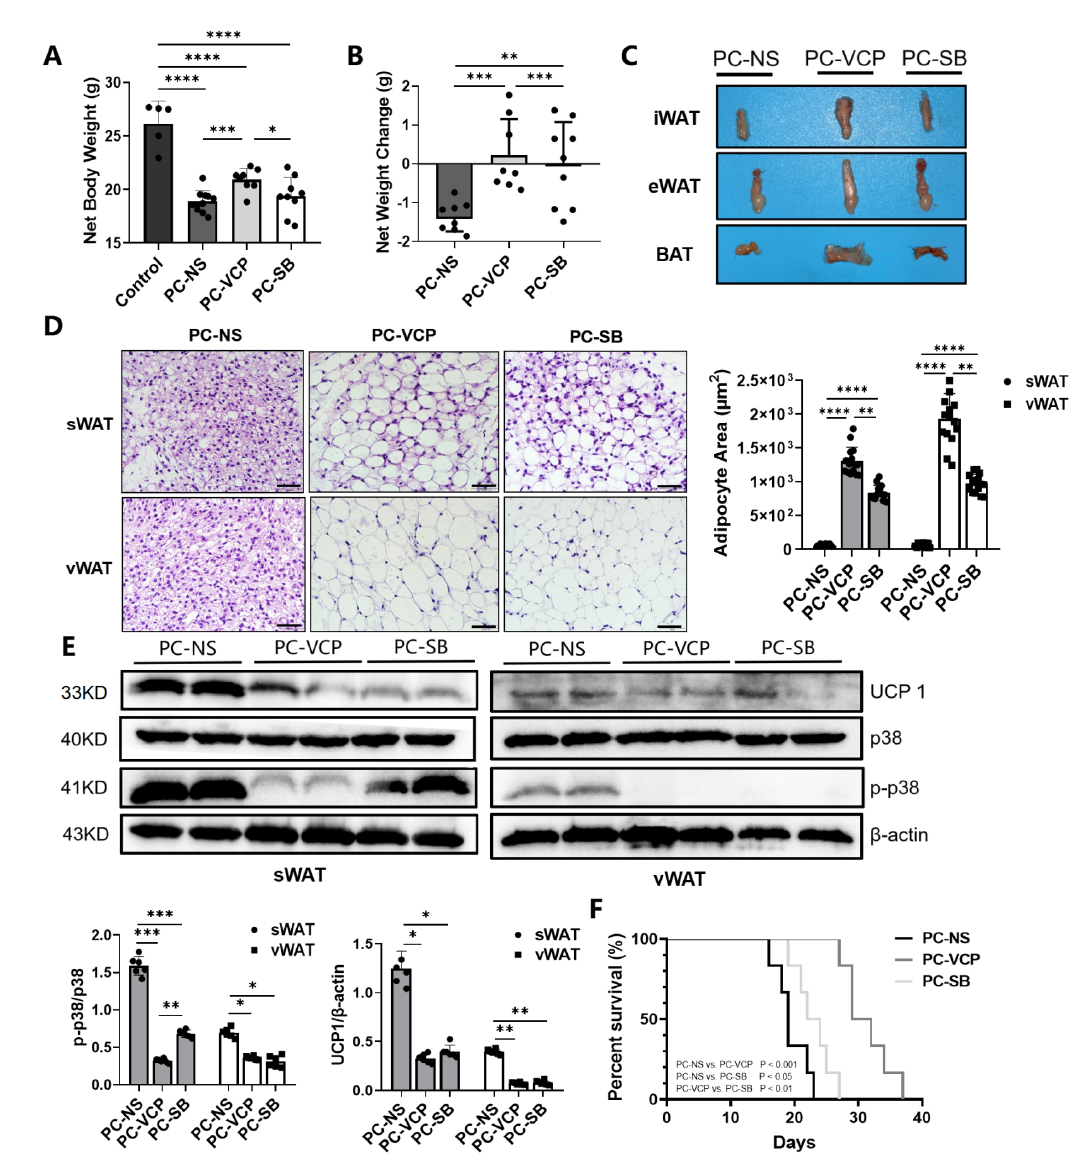
Figure 5. Histological validations of the effect of the p38 MAPK targeted treatment of CAC. ( A ) Com- parison of the net weights of the mice in the three different groups. ( B ) Changes in the net weight of the mice in three different groups. ( C ) Representative iWAT, eWAT and BAT collected from the selected mice of each group. ( D ) H&E staining of sWAT and vWAT and the results from the measurement of adipocytes in the adipose tissue samples collected from the animals in different groups. ( E ) The Western blotting for UCP1 in tissue samples collected from the animals in different groups and their expression levels of UCP1, p38, p-p38 protein of sWAT and eWAT. ( F ) Survival curves of the three groups. (* p < 0.05, ** p < 0.01, *** p < 0.001, **** p < 0.0001). BAT = brown adipose tissue, eWAT = epididymis white adipose tissue, H&E = hematoxylin-eosin, iWAT = inguinal white adipose tissue, p- = phosphorylated, p38 MAPK = protein-38 mitogen-activated protein kinase, PC = pancreatic cancer, sWAT = subcutaneous white adipose tissue, UCP1 = uncoupling protein 1, vWAT = visceral white adipose tissue, WAT = white adipose